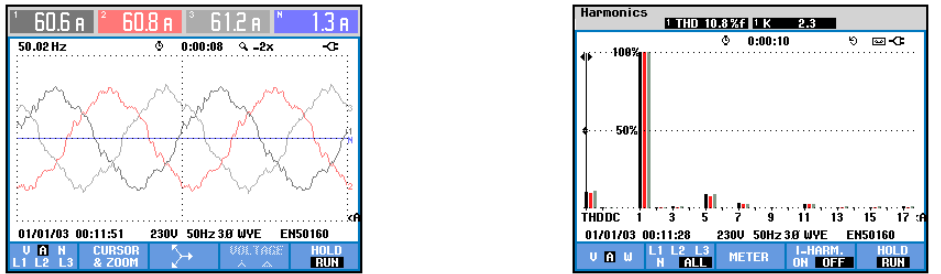
Figure 26. Waveforms of grid current and its harmonic spectra with modified strategy control shunt APF prototype after parallel capacitance load is connected at PCC.